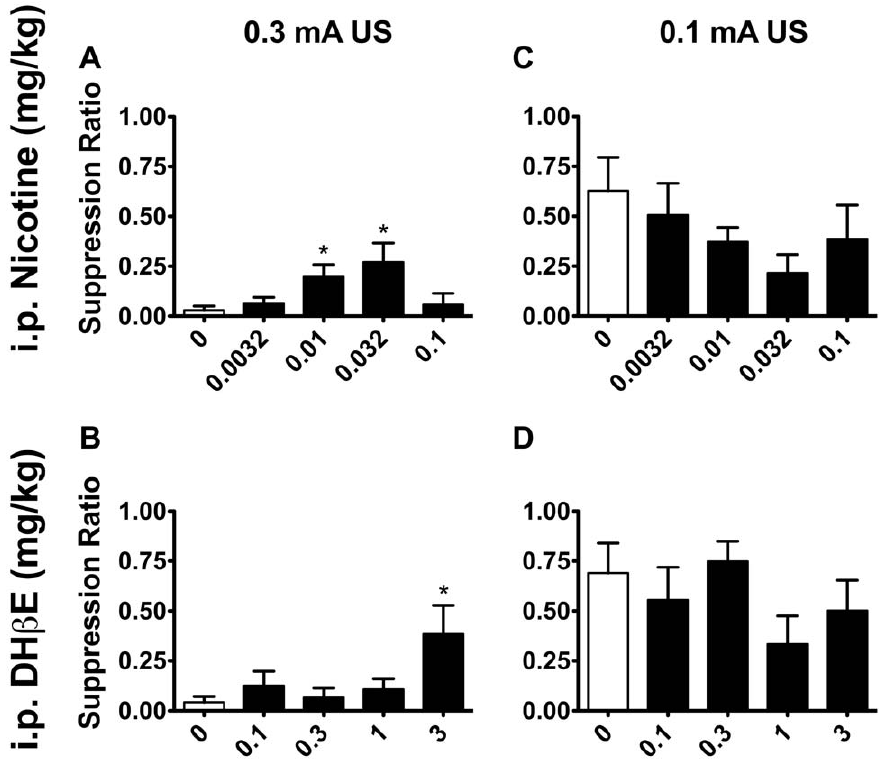
Figure 2. Low dose nicotine and the b 2*nAChR antagonist DH b E reverse conditioned suppression. In mice trained to a 0.3 mA unconditioned stimulus footshock during CER training, A) administration of nicotine resulted in a dose-dependent reversal of conditioned suppression as measured by increased suppression ratios ( F 4,9 =3.101, p , 0.05; n=10). B) The b 2*nAChR antagonist DH b E also resulted in a significant increase in suppression ratios in these mice ( F 4,6 =2.934, p , 0.05; n=7), suggesting that inhibition of b 2*nAChRs supports anxiolytic-like behavior in the CER assay. C, D) Neither nicotine ( F 4,5 =1.991, p . 0.05; n=6) nor DH b E ( F 4,5 =1.263, p . 0.05; n=6) resulted in significant changes in suppression ratio responding in mice exposed to 0.1 mA US footshock during CER training. Data are presented as means 6 SEM. * p , 0.05 compared to when mice received saline control injections.